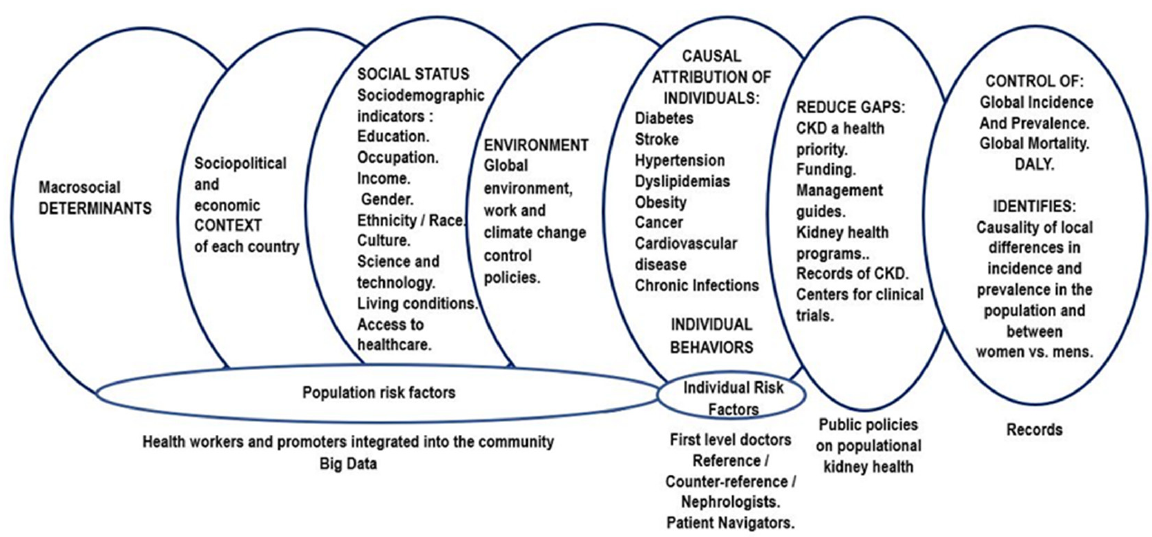
Figure 5. Conceptual framework of the population kidney health model. Source: Authors’ own creation.